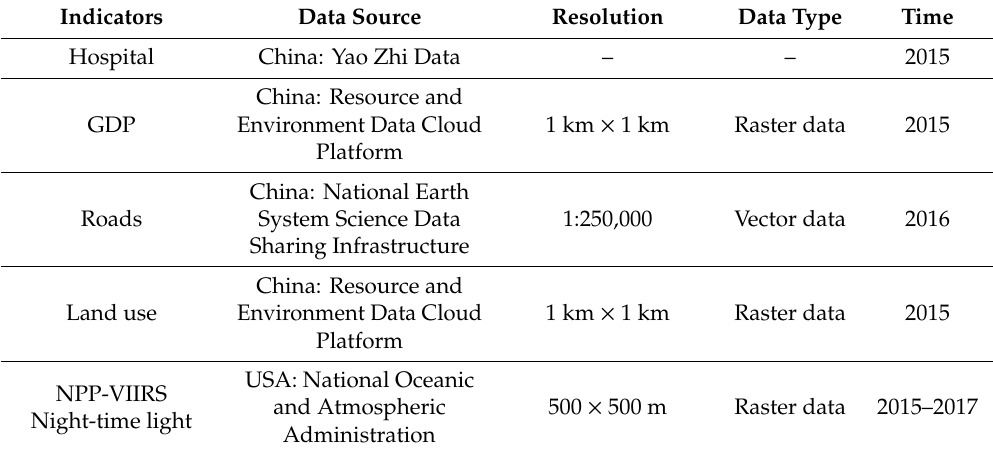
Table 2. Source and resolution of resilience assessment